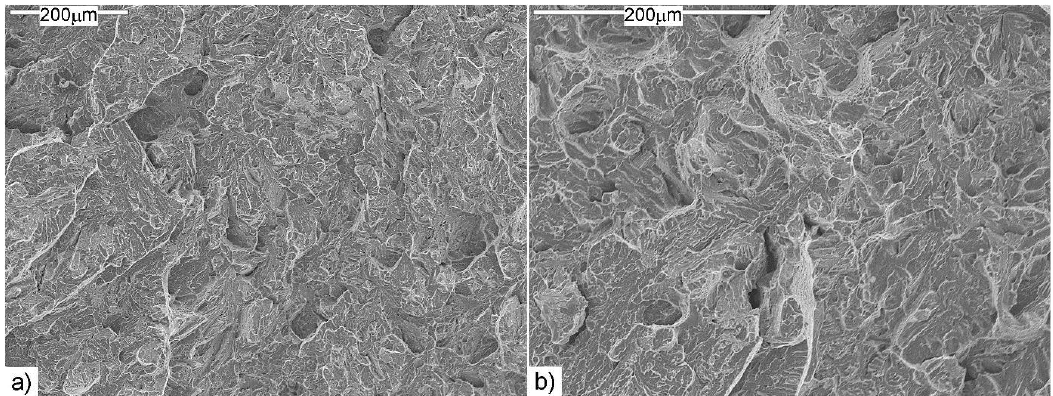
Figure 16. Fracture of the tested sample austenitized at 1200 °C: ( a ) the central zone of the fracture, visible small plastic areas and the typically cleavable areas; ( b ) the ductile bands and transverse crack in the central fracture zone, SEM.